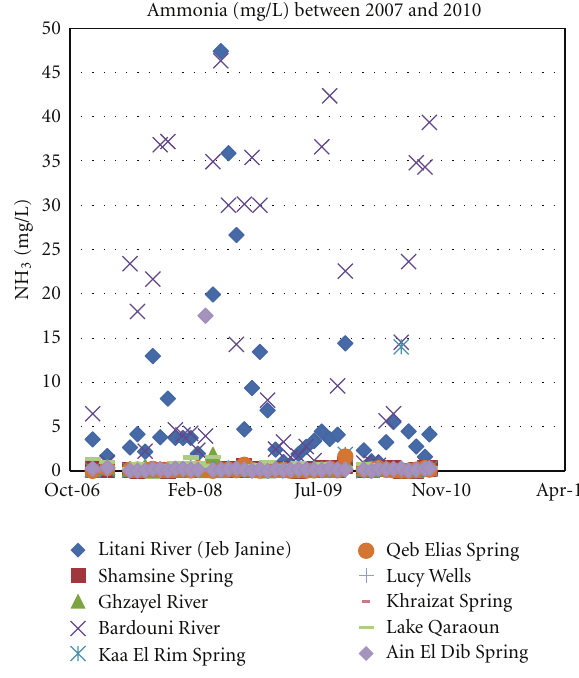
Figure 8: Ammonia levels for years 2007 through